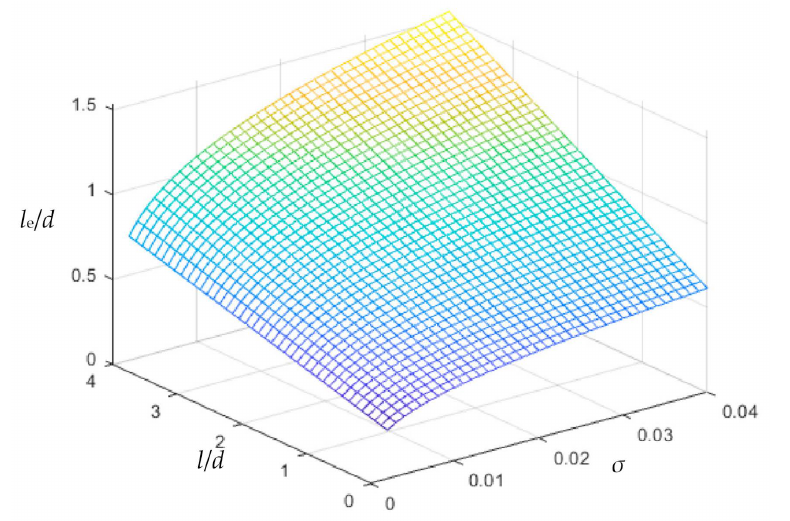
Figure 14. Dimensionless effective orifice length as a function of the ratio of the orifice area to the cavity cross-section area, and the dimensionless orifice